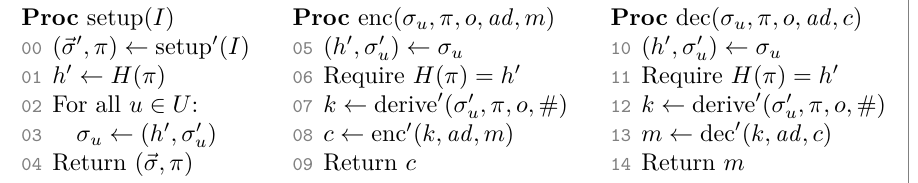
Figure 8: Our RWES construction rwes with procedures setup , enc , dec using procedures setup 0 , derive 0 of a generic KAS kas and procedures enc 0 , dec 0 of a generic AEAD scheme aead. In [07,12] we write # for any fixed associated-data string. If the conditions in [06,11] are not fulfilled, the respective algorithm